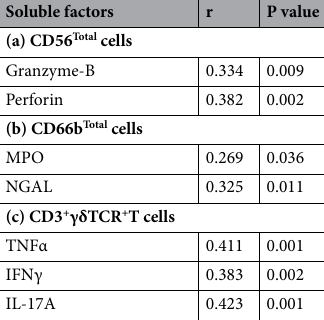
Table 1. Association between ocular surface immune cell type proportion and their characteristic secretory factors levels in the tear fluid of study subjects. r = Spearman rank correlation coefficient.